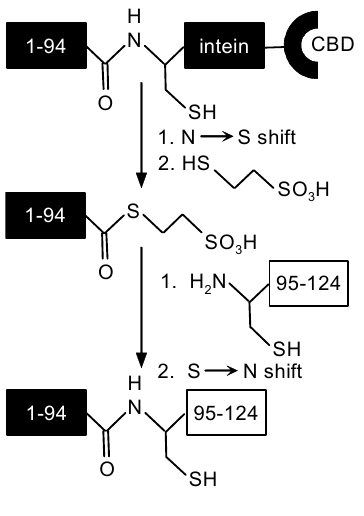
FIGURE 1. Scheme for semisynthesis of RNase A by intein-mediated protein ligation. N-terminal part (1–94, black box) is produced by biosynthesis, C-terminal part (95–124, white box including Cys95) is produced by chemical